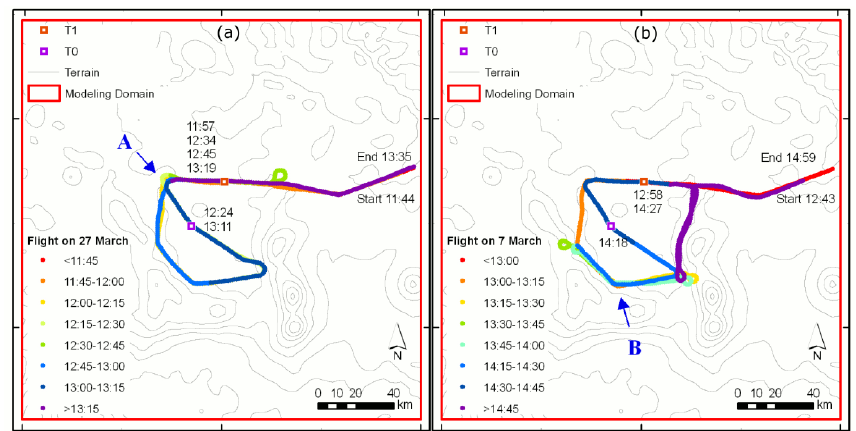
Fig. 6. Flight track of the G-1 aircraft on (a) 27 and (b) 7 March with starting, ending, and sampling time stamps at each supersite from MCMA-2006 field campaign are shown; T0 (purple) and T1 (orange). Rainbow colors correspond to the measurement time. Topography contour intervals are 400m. Letter A and B denote the location where flights passed multiple times.